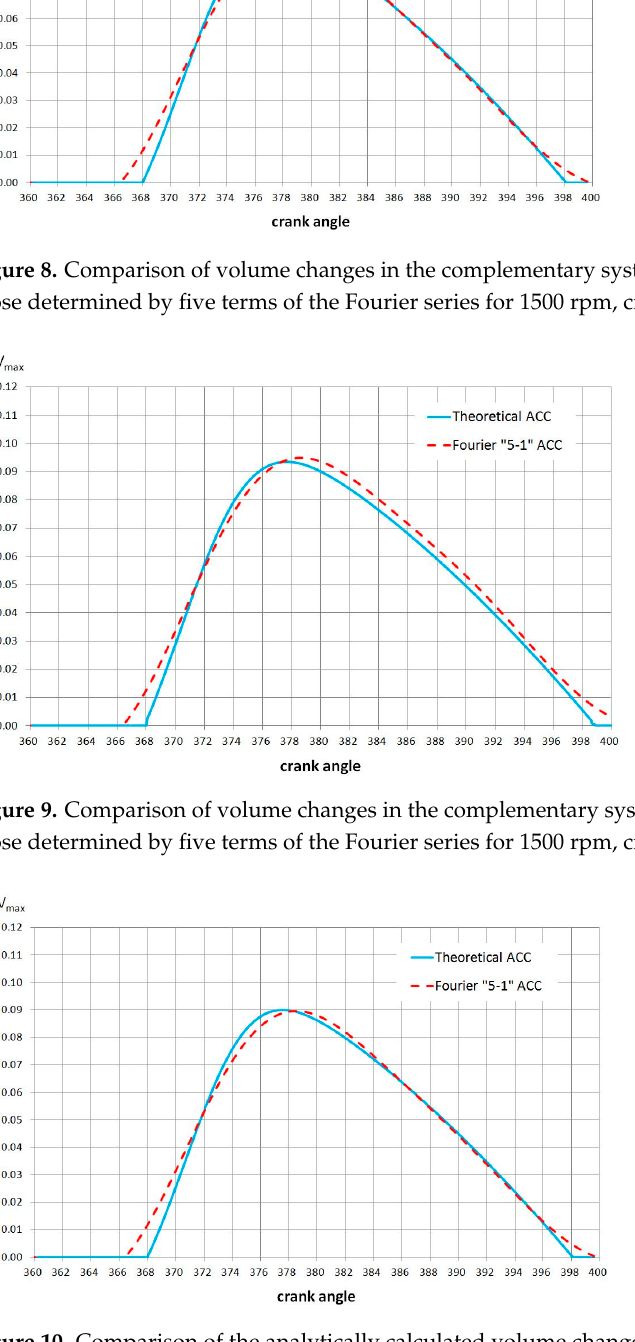
Figure 10. Comparison of the analytically calculated volume changes in the complementary system with those determined by five terms of the Fourier series for 1500 rpm, cr = 20:1.